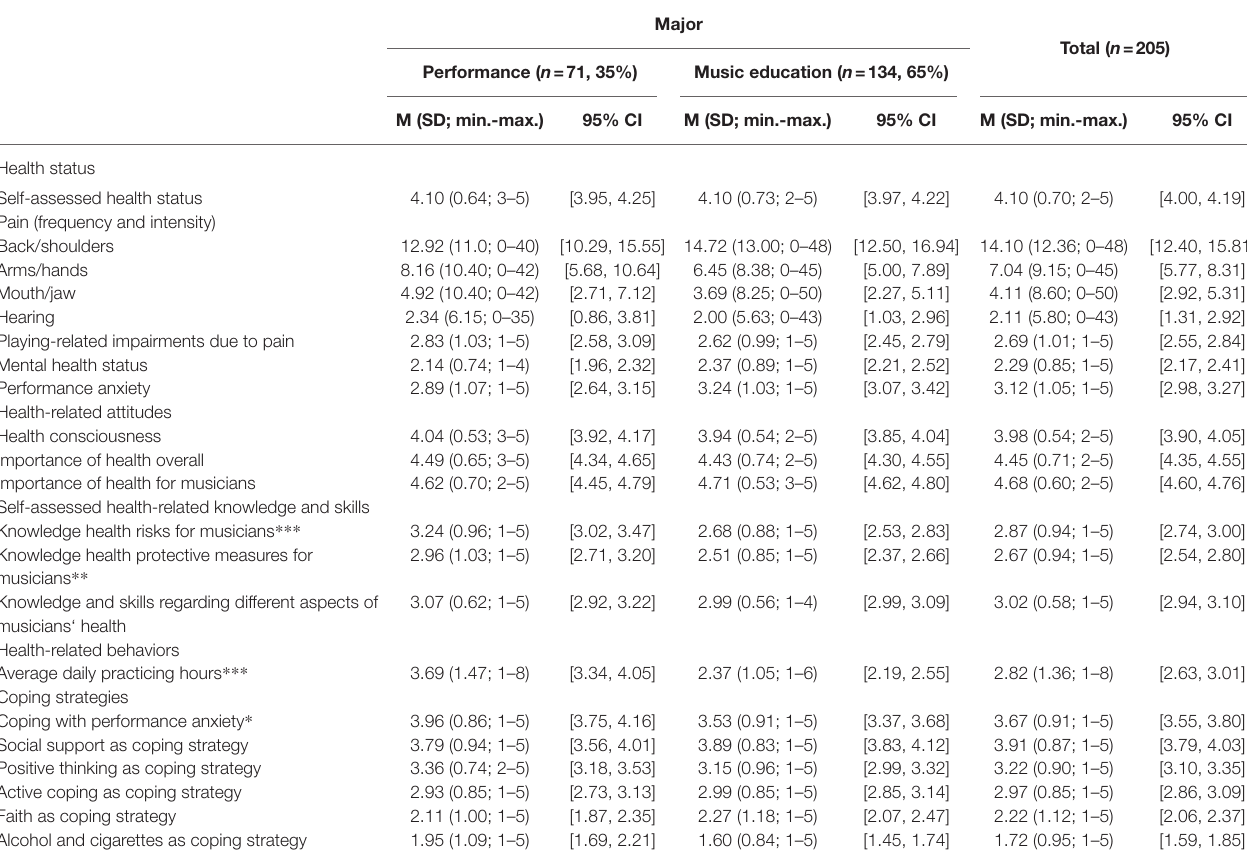
TABLE 3 | Health status, health-related attitudes, knowledge, skills and behaviors, and coping strategies of first-year music students (performance majors and music education majors). Major Total ( n = 205) Performance ( n = 71, 35%) Music education ( n = 134, 65%) M (SD; min.-max.) 95% CI M (SD; min.-max.) 95% CI M (SD;